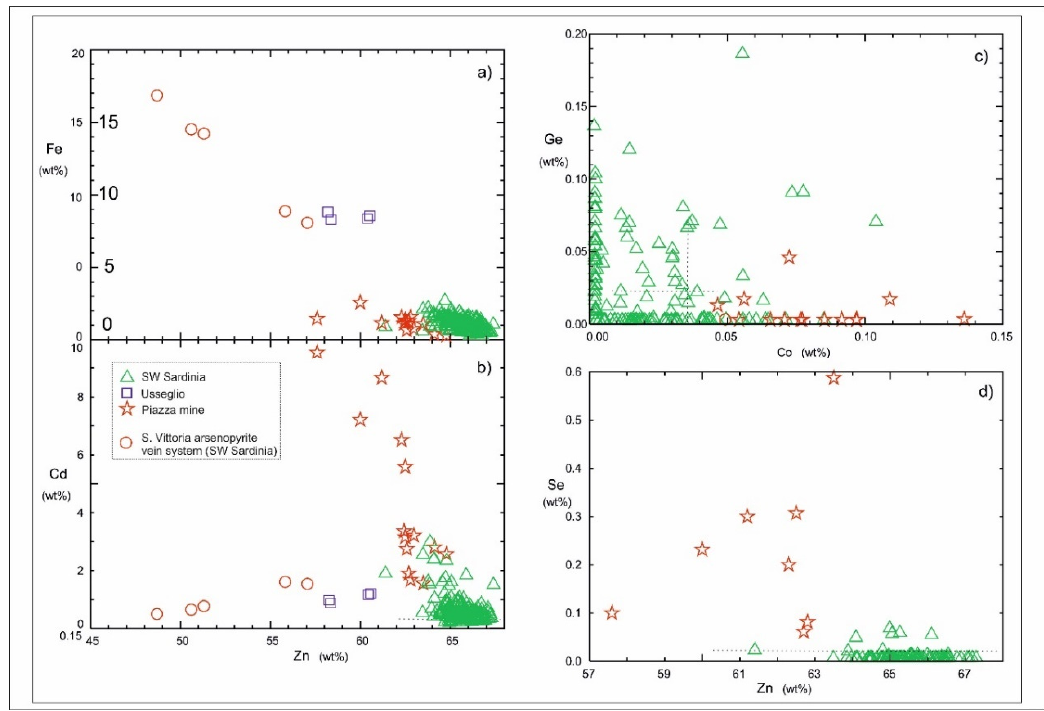
Figure 7. Plots of the sphalerite data (weight%). ( a ) and ( b ) binary diagrams of Zn vs. Fe and Cd involving sphalerites from SW Sardinian, Usseglio and Piazza deposits and comparing them with the composition of accessory sphalerite from arsenopyrite veins affiliated to the high-temperature Sn–Mo–As ores near Sa Menga [18]. ( c ) and ( d ) binary diagrams comparing Ge, Co, and Se contents in sphalerites from the SW Sardinian and Piazza ore deposits.